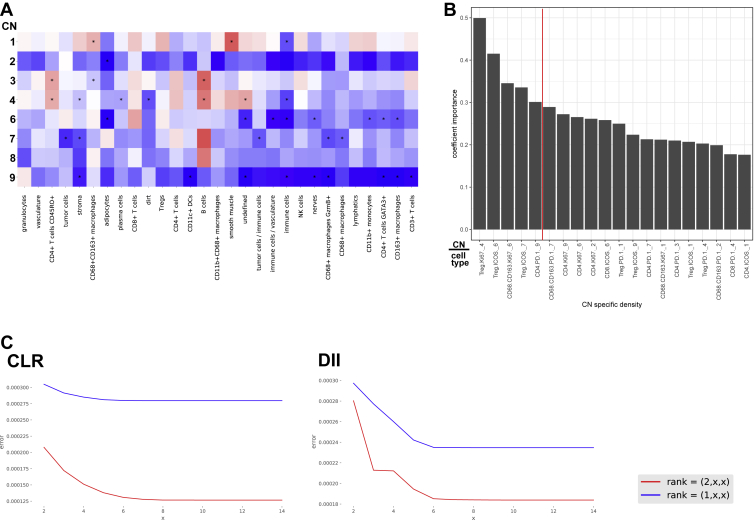
Heatmap of Estimated Differential Enrichment Coefficients, Feature Importance for the Classification Model, and Elbow Points for Tucker Tensor Decomposition, Related to Figure 6 and STAR Methods(A) Heatmap of estimated differential enrichment coefficients for cell types not shown in Figure 6G. Asterisks indicate CNs and cell types with a regression p value < 0.05 (not adjusted for multiple tests). A positive coefficient (red) indicates that the corresponding cell type is more enriched in DII patients than in CLR patients in the given CN. (B) Feature importance for classification model. Bar plot of absolute coefficient z-scores for CN-specific cell type frequencies, estimated from a model classifying patient groups using iterative resampling, as described in Figure 6F. The five CN-specific cell type frequencies with a coefficient importance of 0.3 or higher (left to red dotted line) were considered for assessment with respect to survival in DII patients. (C) Elbow points for Tucker tensor decomposition. Tensor decomposition loss for choices of rank in patient space, CN space, and cell-type space used for selection of decomposition rank in each patient group. Blue lines, one tissue module; red lines, two tissue modules. The elbow point was found at 6 CN modules and cell type modules (red line).